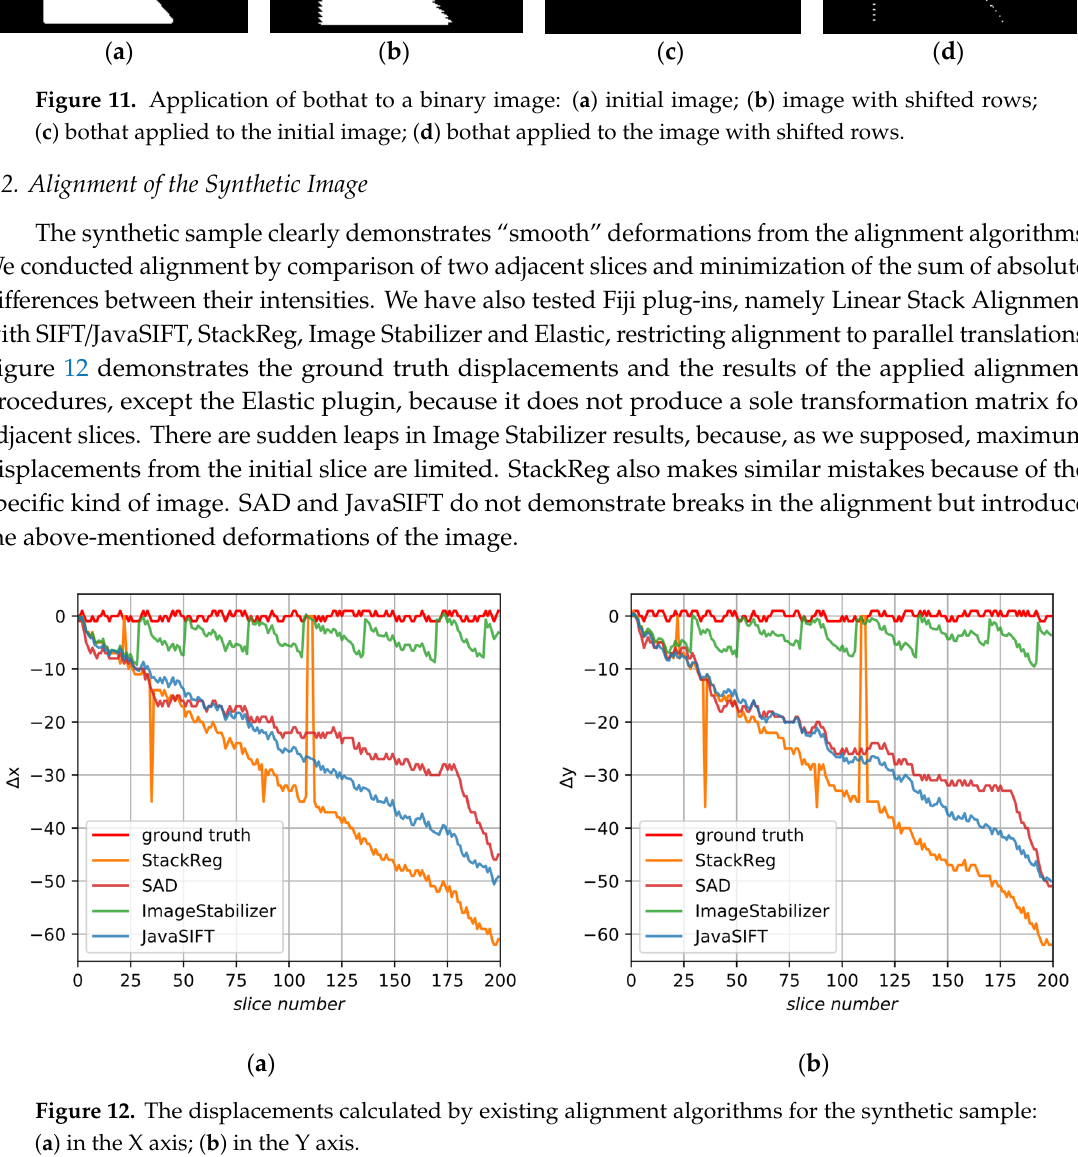
( b ) Figure 13. The displacements found by the proposed algorithm for the synthetic sample: ( a ) in the X axis; ( b ) in the Y axis. Side views of the GT and aligned images are demonstrated in Figure 14. As one can see, the conventional methods have changed the 3D image in an unpredictable manner, resulting in a completely different sample structure, and only the proposed algorithm has preserved the initial geometry.